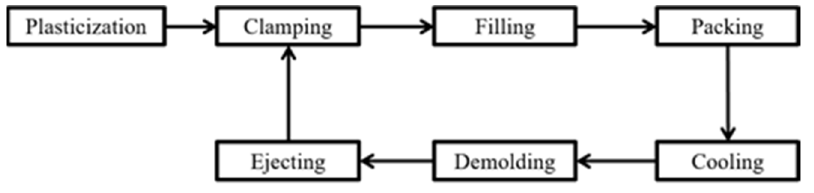
Figure 1. Flow chart of injection molding process.